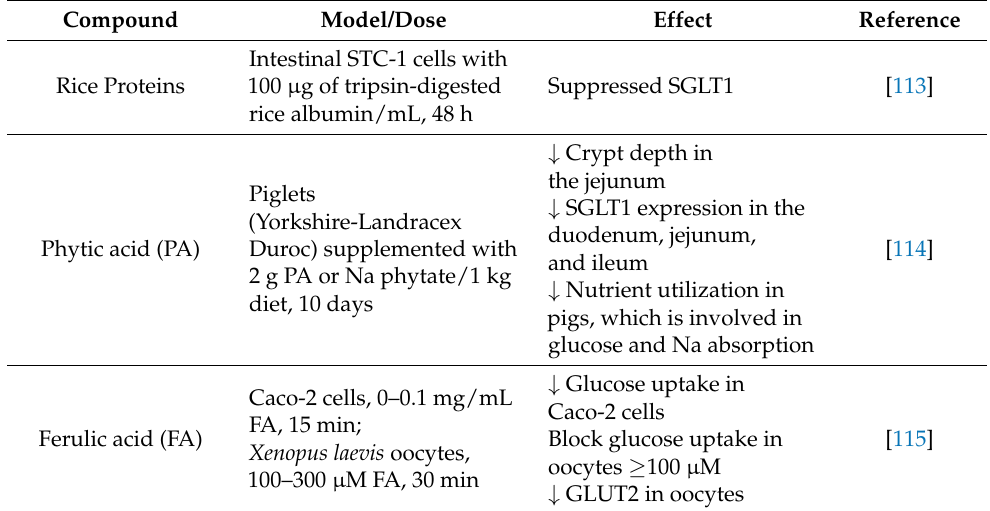
Table 6. Effect of macronutrients and bioactive rice compounds in the modulation of SGLT1 and GLUT2. Compound